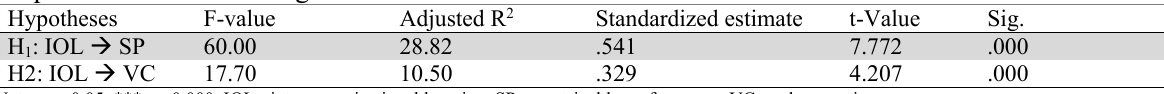
Empirical results: linear